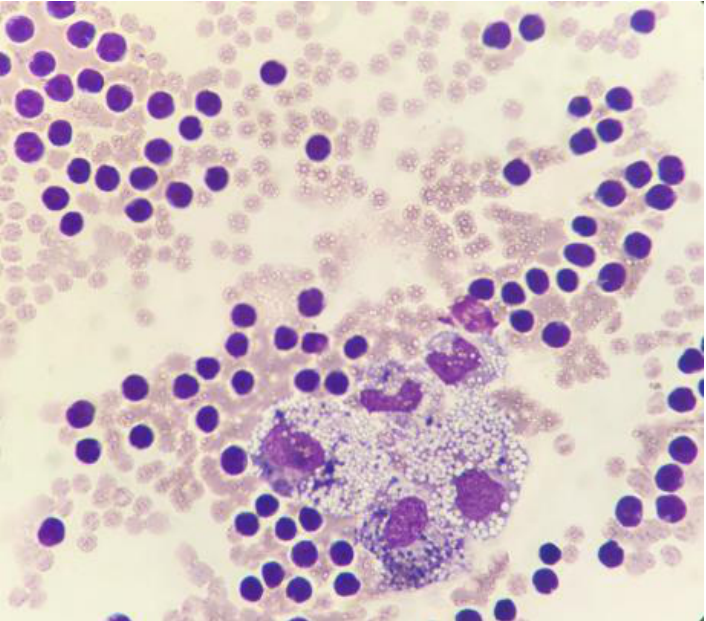
Figure 3. Cytocentrifuged specimen of the pericardial effusion. A moderate hematic background is present along with a mixed cell population consisting mainly of small lymphocytes and macro- phages containing both lipid droplets and hemosiderin. May–Grunwald Giemsa, 100×. containing both lipid droplets and hemosiderin. May–Grunwald Giemsa, 100 ×